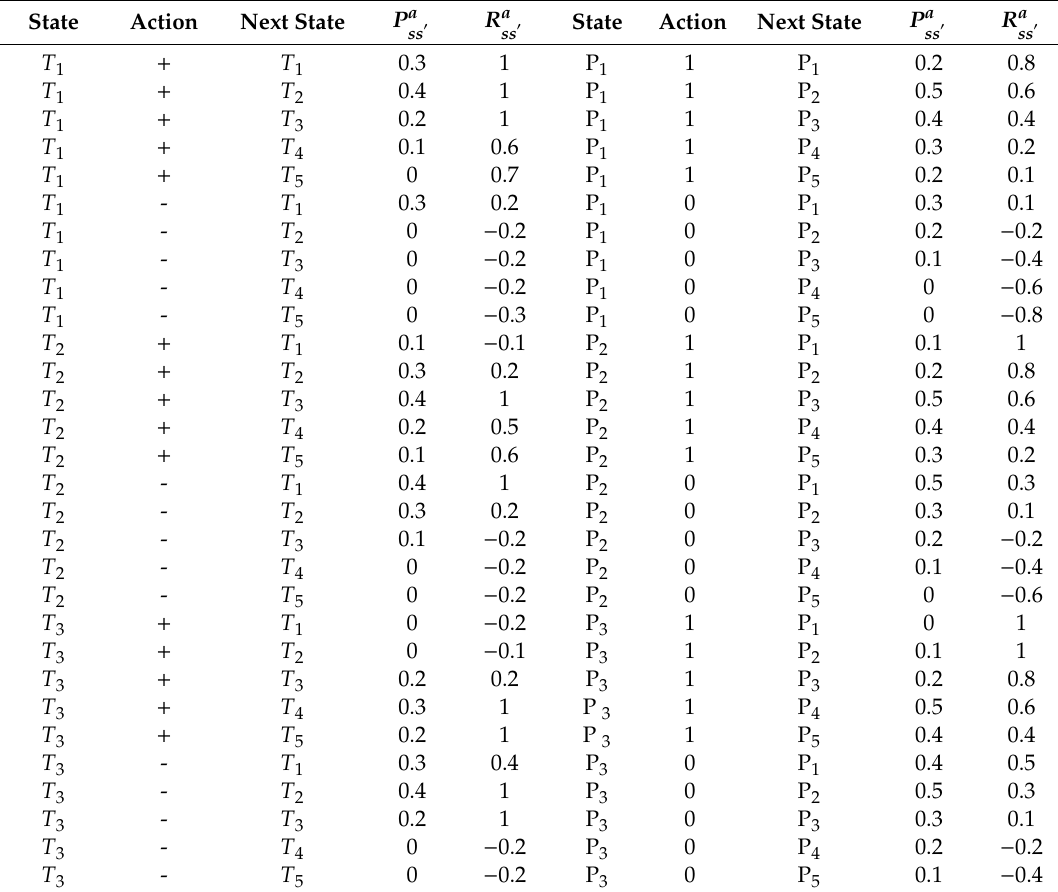
Table 13. The transition and reward probability of RL-based